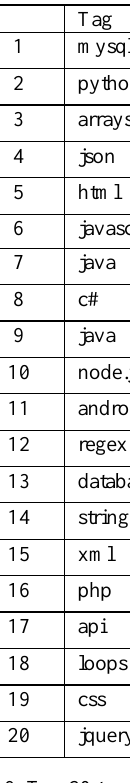
Table 9. Top 20 tags with the highest closeness centrality